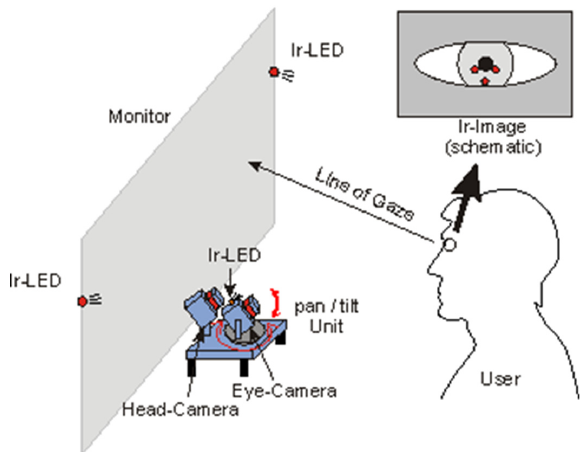
Figure 4. Eye-tracking system. (Source: http://www.kt.e-technik.tu-dortmund.de/cms/en/research/ finished_projects/eye_tracking/).